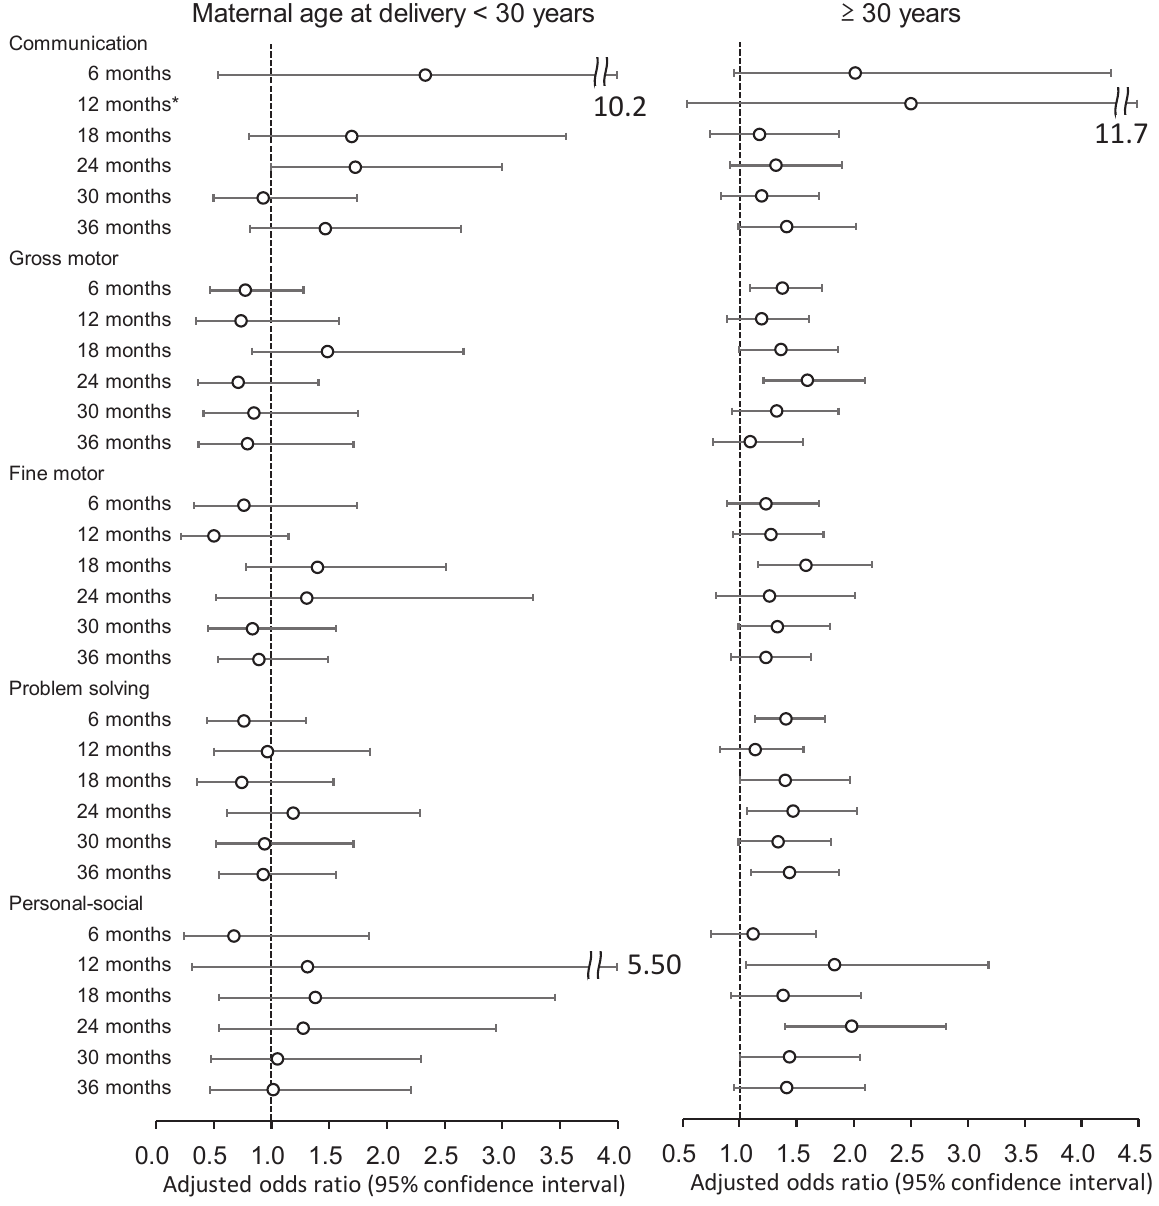
Fig. 3 Association of epidural analgesia with neurodevelopmental delay among children, by maternal age Adjusted odds ratios (95% con fi dence intervals) for neurodevelopmental delay in each domain of the J-ASQ-3 among children born to mothers who received epidural analgesia during labor are shown from age 6 to 36 months, strati fi ed by maternal age at delivery ( < 30 years / ; 30